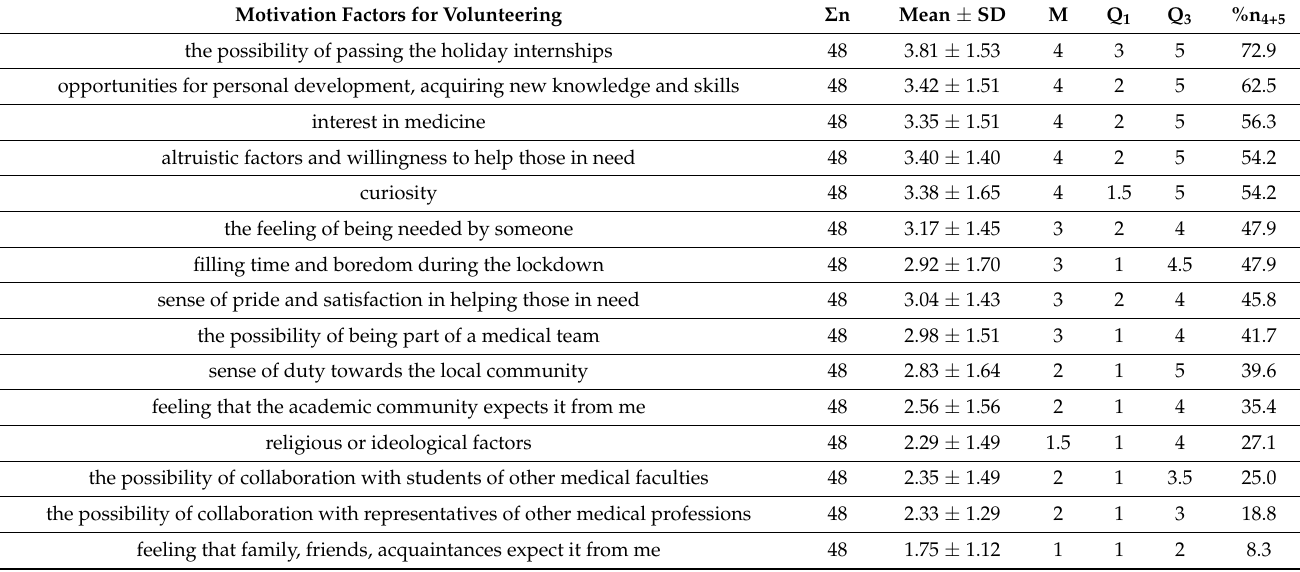
Table 5. The impact of individual factors on the motivation to participate in